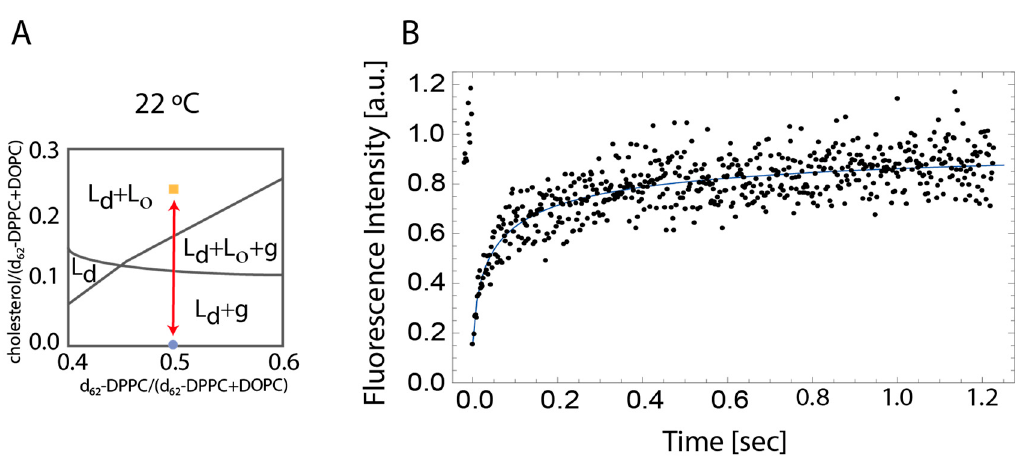
Figure 1. ( A ) Schematic indicating the different equilibrium state at 22 °C between the analyzed membranes adapted from Marsh [9] ( B ) Representative FRAP recovery curve at 22 °C for 2:2:1 DOPC:DPPC:Cholesterol membrane. The blue curve is fitted by using the line FRAP equations (see Equations (1)–(3).